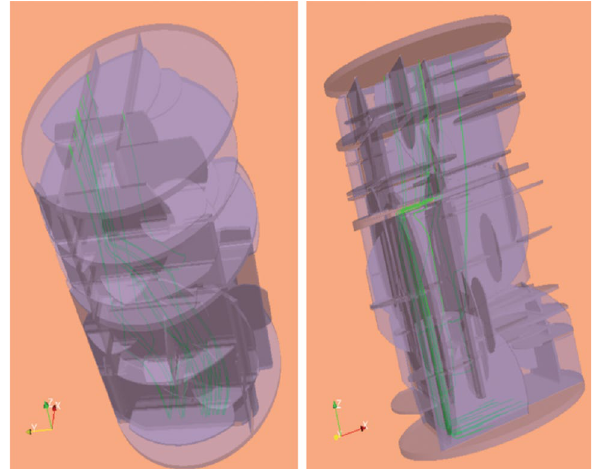
Figure 7. Streamlines (green lines) in fracture network simulated in OpenFOAM.